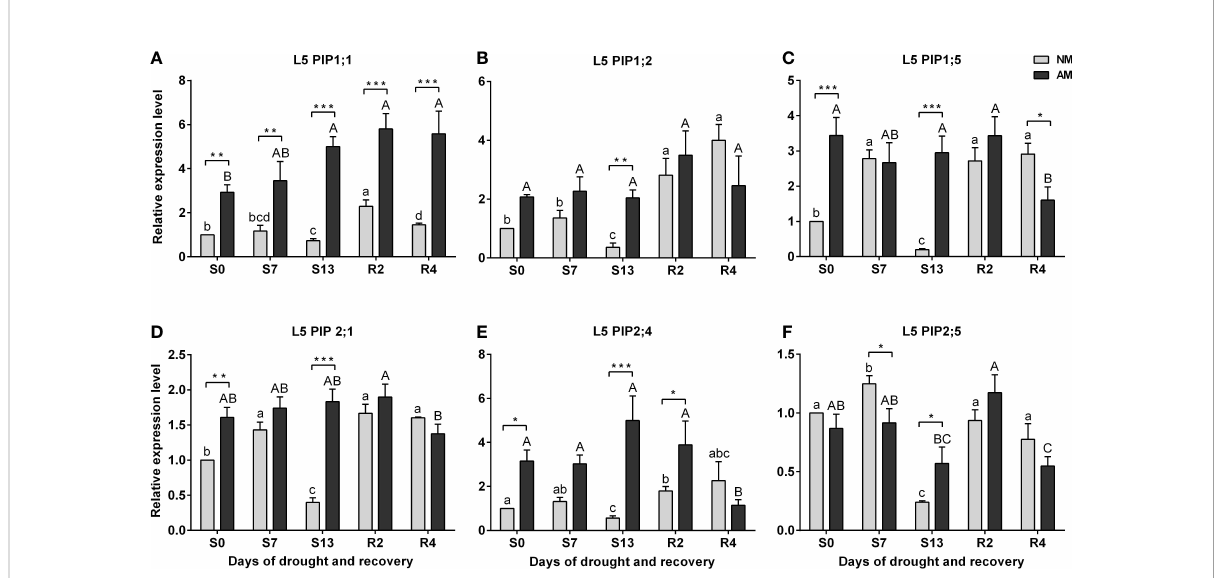
FIGURE 6 Analysis of aquaporins (A) PIP1;1 , (B) PIP1;2 , (C) PIP1;5 , (D) PIP2;1 , (E) PIP2:4 , (F) PIP2;5 transcipt accumulation in leaf 5 (L5) during the development of drought (S0-S13) and rehydration (R2, R4). The results were normalized to the expression of reference gene 18S RNA and presented as a relative to S0 time point for NM plants. The bars represent mean values (n=6) and standard error of mean of three technical replicates taken from two independent cultures as extracts from a mix of leaf strips from six plants of each symbiotic variant. The asterisks show statistically signi fi cant differences between NM and AM calculated using Student ’ s t -test (* p <0.05, ** p <0.01, *** p <0.001). Lower-case letters show signi fi cant differences between NM means and upper-case letters signi fi cant differences between AM means in following days calculated using ANOVA